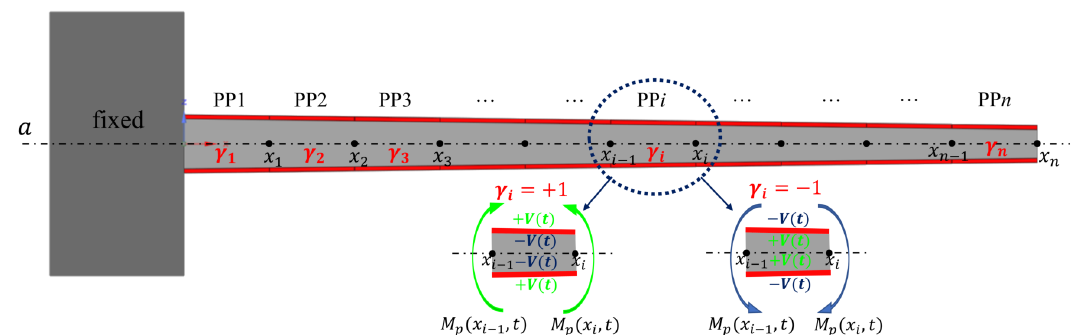
Figure 2. Cantilever tapered beam coupled with n PZT actuator pairs (PPs). a denotes the axis of symmetry, x i − 1 and x i are, respectively, the left and right edges of the i -th PP. The step function γ i assumes + 1 or − 1 values and it is used to denote the two possible voltage distributions which can be provided to the generic i -th PP in order to induce two bending moments in the beam.